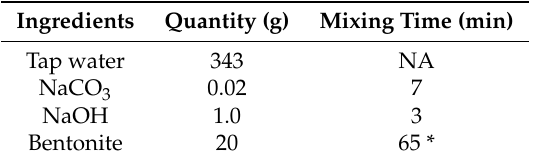
Table 3. Mix design and mixing procedure for the bentonite pill.